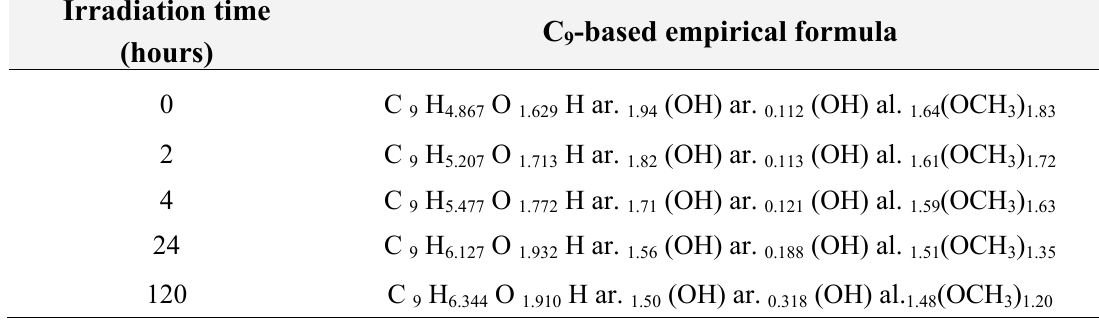
Table 3. Expanded empirical formulas of BCMP acidolysis lignin and irradiated lignin samples based on C